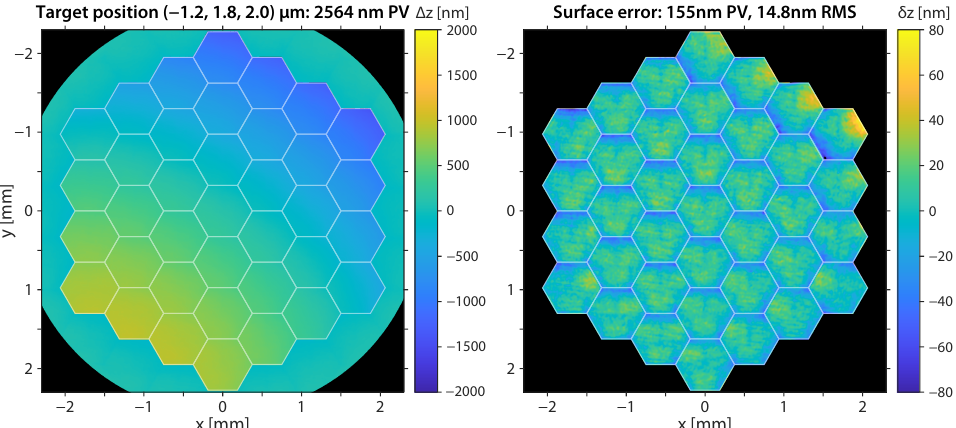
Figure 9. Illustration of a measured deformable mirror topography for positioning the laser beam focus at (−1.2, 1.8, 2.0) μ m. The shape error was most pronounced at the minimal actuator dis- placement in the top-right corner.